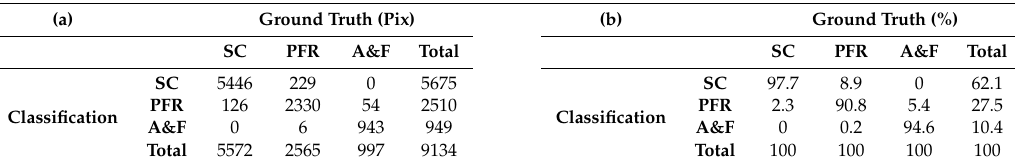
Table 4. Contingency matrices between classification results and field information collected in summer campaigns, expressed in pixels ( a ) and in percentage ( b ). The field data correspond to the evaluation subset and groups information of all RPG sub-regions and all the agricultural years. SC: Summer Crops, PFR: Perennial Forage Resources, A&F: A ff orestations and Forests.